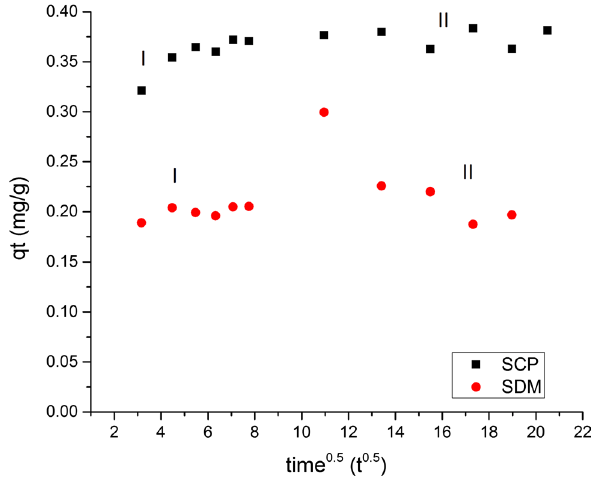
Fig. 4 Pseudo-second-order kinetic graph for adsorption of SCP and SDM onto Fe-MC ( m = 0.1 g/50 mL, C i = 1 ppm, pH = 6.4)